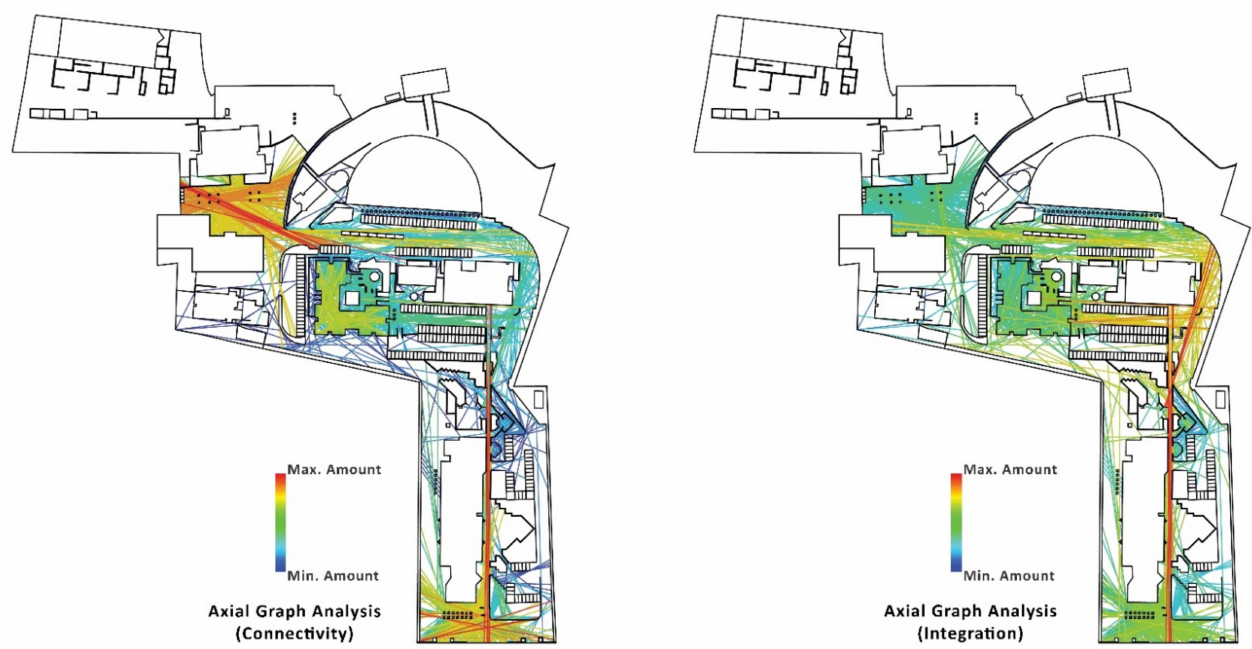
Figure 8. Axial map for the academic section of the